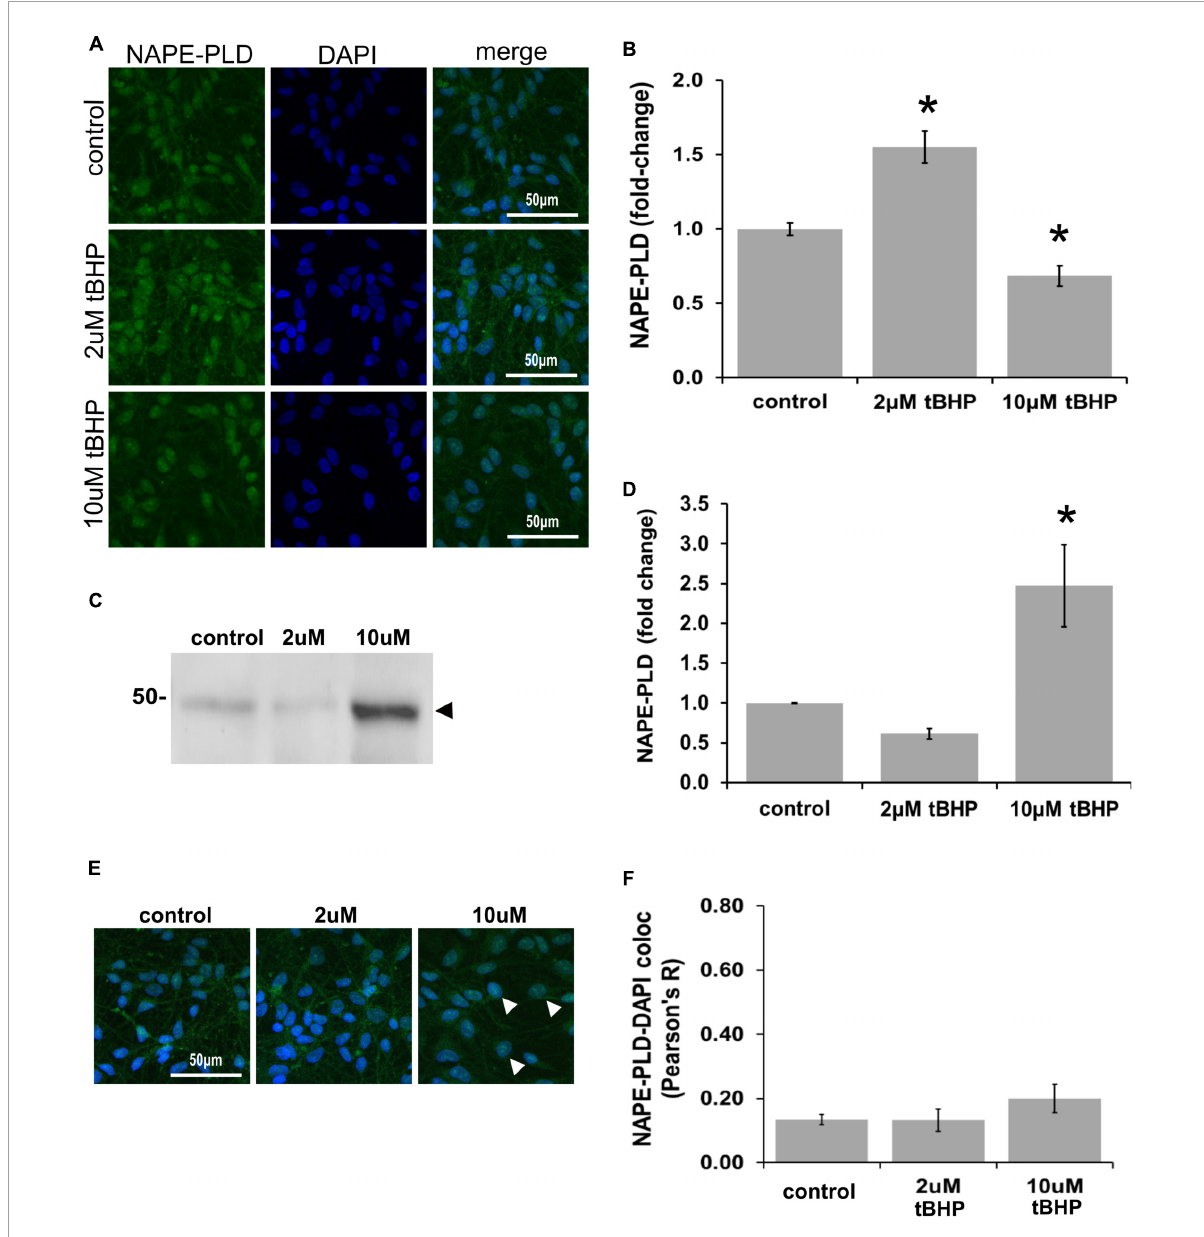
FIGURE6 Expression of N -acyl phosphatidylethanolamine phospholipase D (NAPE-PLD) in ReN cells under conditions of oxidative stress. (A) ReN cells express NAPE-PLD in the soma and nucleus. (B) Exposure of ReN cells to tert-butylhydroperoxide (tBHP) resulted in a biphasic NAPE-PLD expression pattern–2 µ M tBHP led to a 20% increase in NAPE-PLD expression. Green fluorescence is NAPE-PLD and blue fluorescence is DAPI. (C,D) Western blot analysis reveals that the expression of a 48 kDa band (expected molecular weight is 45.6 kDa) corresponding to NAPE-PLD is upregulated 2.4-fold by exposure to 10 µ M tBHP. (E,F) Colocalization analysis on image stacks reveals that there is little colocalization between NAPE-PLD and DAPI (Pearson’s R value < 0.20) except for when cells are exposed to 10 µ M tBHP, a concentration that increases colocalization to Pearson’s R of 0.20. * p ≤